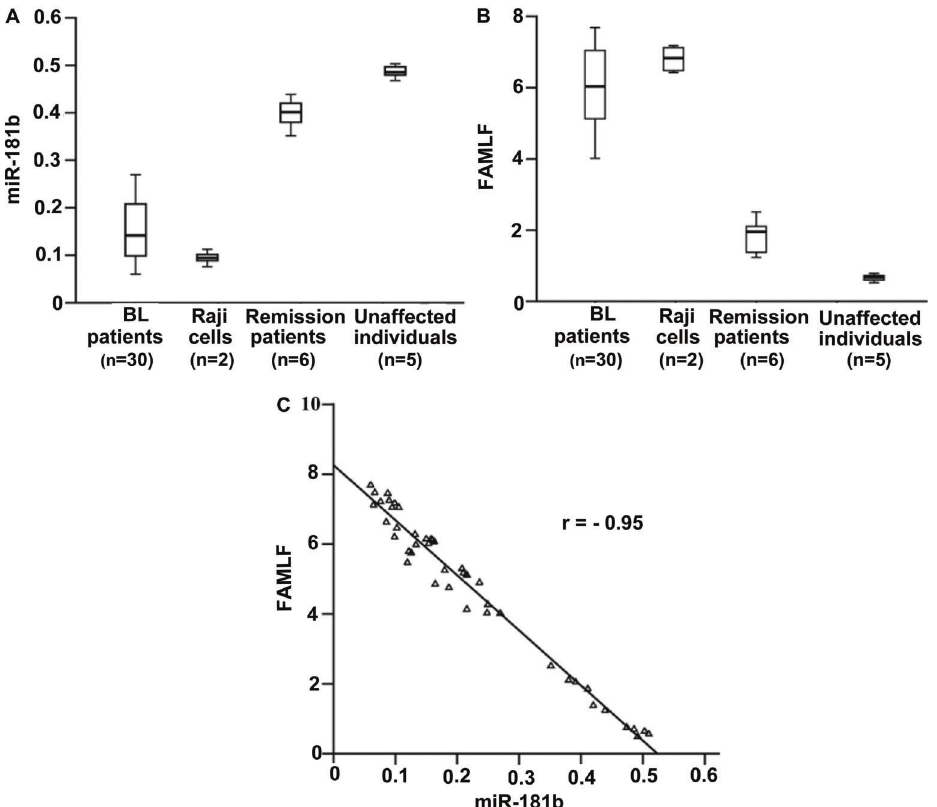
Figure 2. Expression of miR-181b and FAMLF in Burkitt lymphoma (BL) patients, Raji BL cells, remission patients and unaffected individuals. A , miR-181b was little expressed in BL patients and Raji BL cells, but highly expressed in remission patients and unaffected individuals. B , FAMLF was highly expressed in BL patients and Raji BL cells, but little expressed in remission patients and unaffected individuals. C , FAMLF expression was inversely correlated with miR-181b expression. Data are reported as means ± SD. P o 0.01 (Pearson